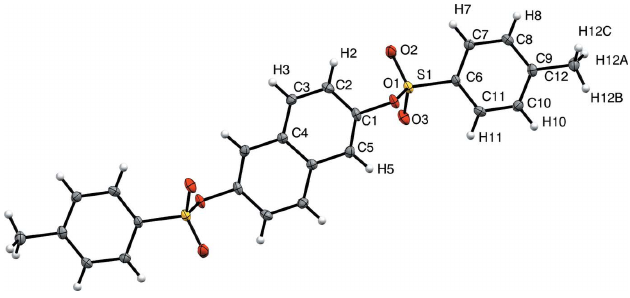
Figure 1 The molecular structure of the title compound with displacement ellipsoids drawn at the 50% probability level. Unlabelled atoms are generated by the symmetry operation 2 (cid:3) x, 1 (cid:3) y, 1 (cid:3) z.